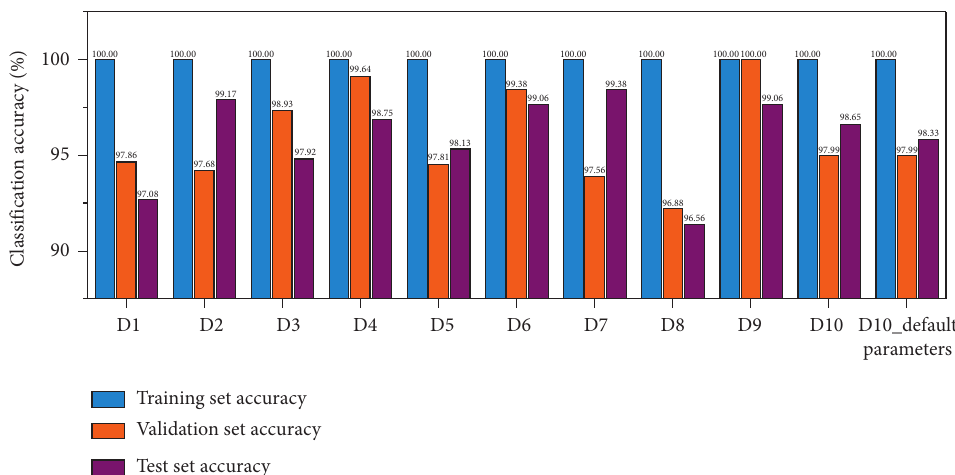
Figure 15: The classification results of the 10 datasets used for experimental